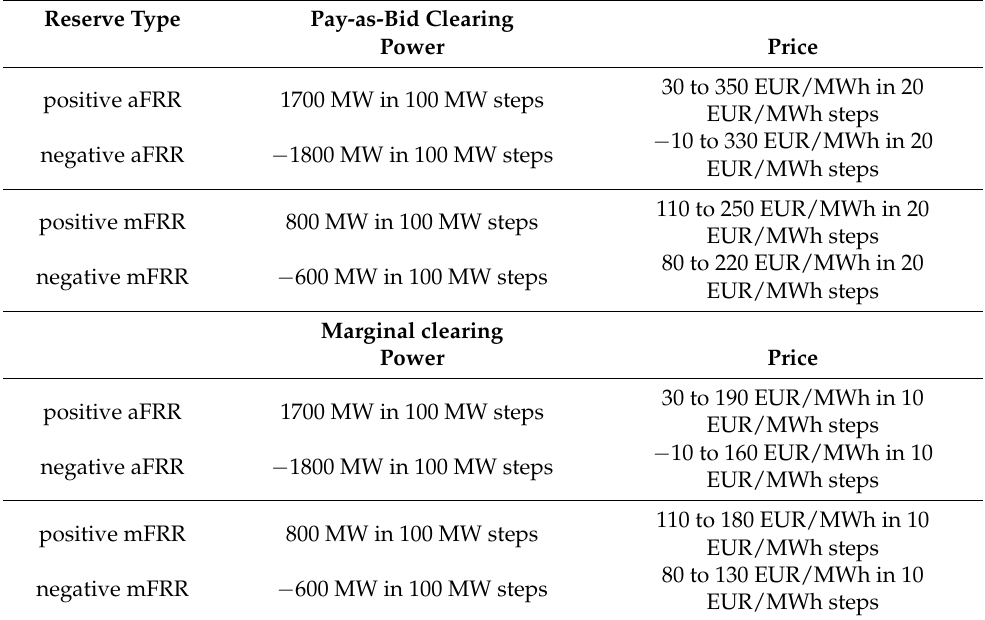
Table 4. Synthetic Merit-Order-Lists (MOLs) for smart balancing